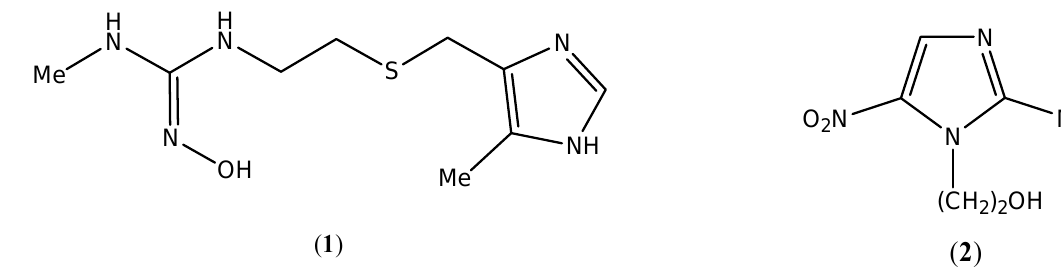
Figure 1. Model imidazole-based synthetic